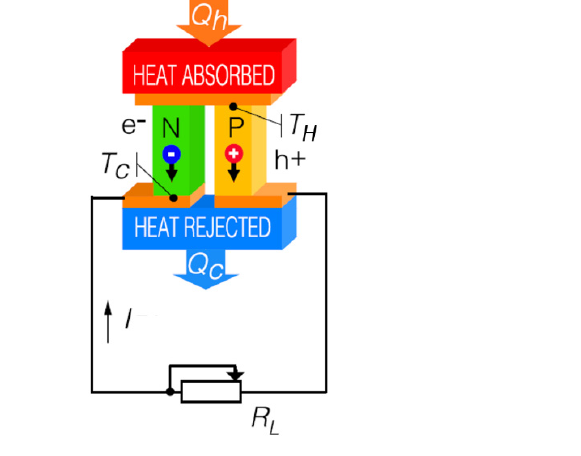
Figure 1. Scheme of a thermoelectric generator where Q h is the absorbed heat flow, Q C is the dissipated heat flow and I is the electrical current. See text for other variables.